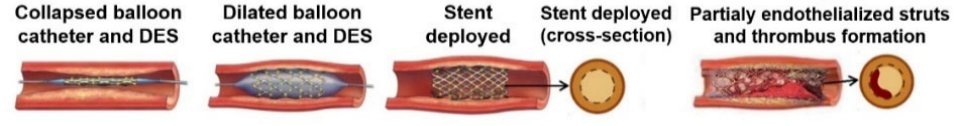
Figure 3. Late thrombosis after drug-eluting stents, reproduced with permission from and modified from [3].